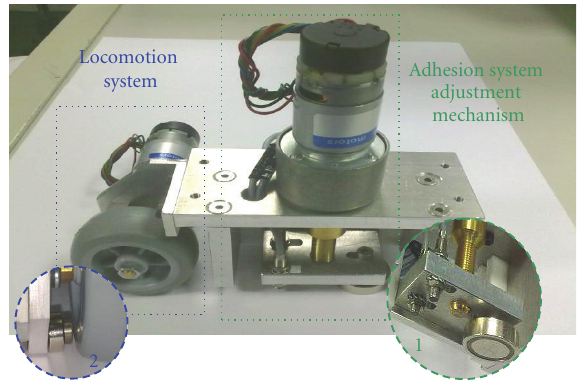
Figure 2: Modular standard unit, where it is visible the locomotion system (left) and the adhesion system dynamic adjustment mecha- nism